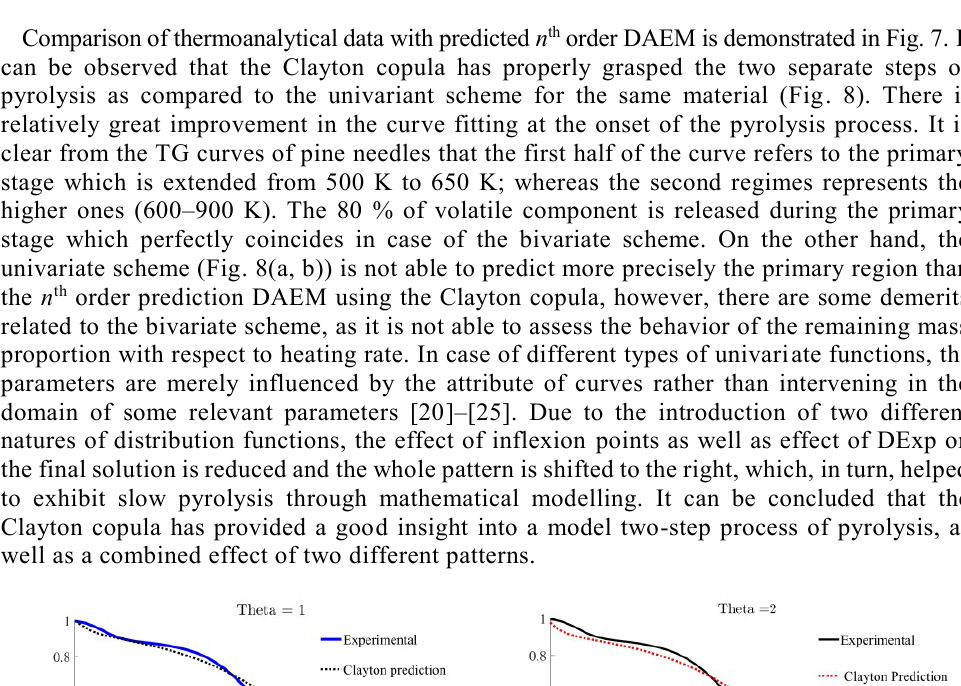
Fig. 6. The effect of reaction order ( n ) on the numerical results of bi-variant scheme for DAEM: (a) θ = 1; (b) θ = 2 ( A = 1.5·10 −005 s −1 , η = 10 −9 kJ/mol, m = 10 °C min −1 and β = 0.0920).